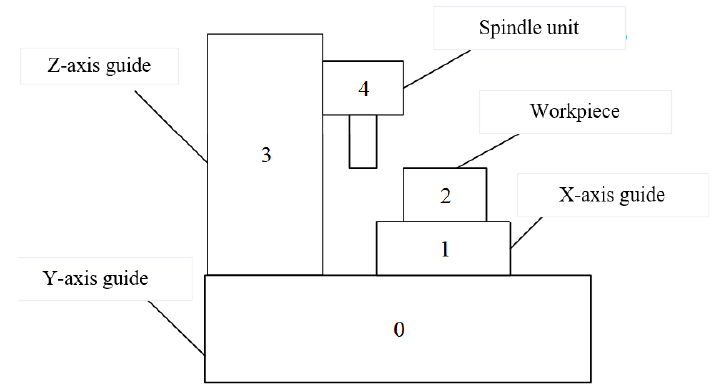
Figure 17. Overall structure diagram.